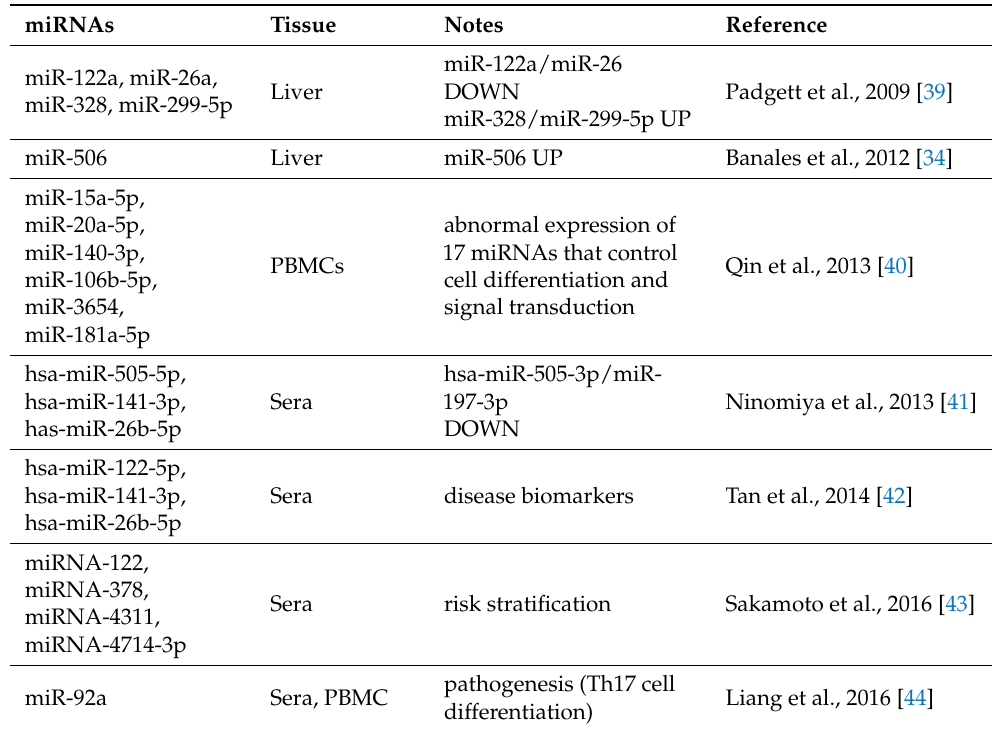
Table 1. Dysregulation of miRNAs in Primary Biliary